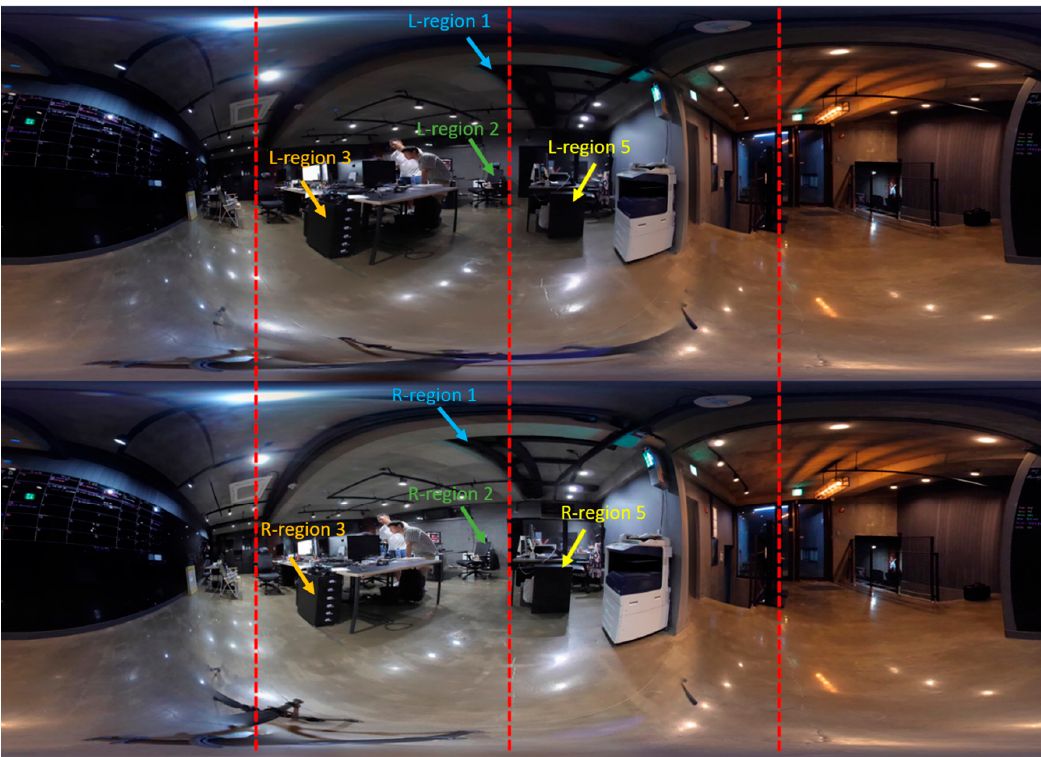
Figure 12. The final 3D stereo panorama generated by our proposed system, which provides a 3D view by stacking the left stereo panorama on the top of the right stereo panorama. Since the stereo panorama has di ff erent views for the left and right eye, the perceptual di ff erences for both eyes are demonstrated in the left and right stereo panorama using certain regions. Where the perceptual di ff erence for each selected region in both the left and right stereo panorama is highlighted using arrows, the same regions in di ff erent panoramas (left and right) are highlighted with the same color.